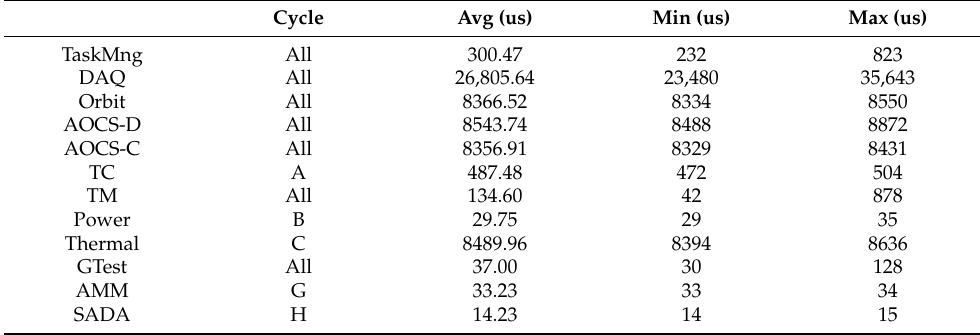
Table 4. Time consumed and operation cycle of each module.